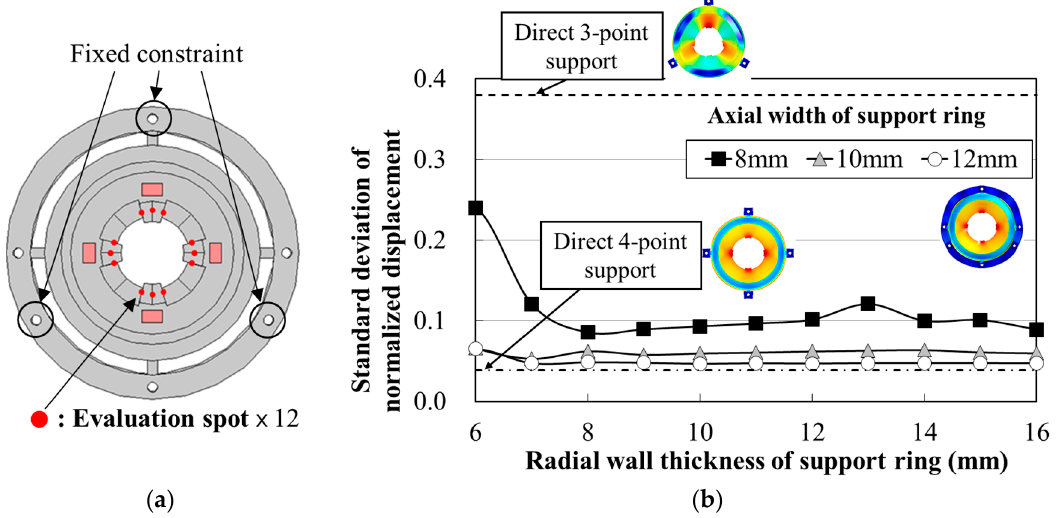
Figure 8. Analysis of support ring effects on stator. ( a ) Fixed portions of support ring and evaluation spots in the rotor contact portion of the stator; ( b ) Calculated standard deviation of the normalized simulated vibration amplitude of the stator at the evaluation spots during R 1 -mode excitation in finite element analysis (FEA).